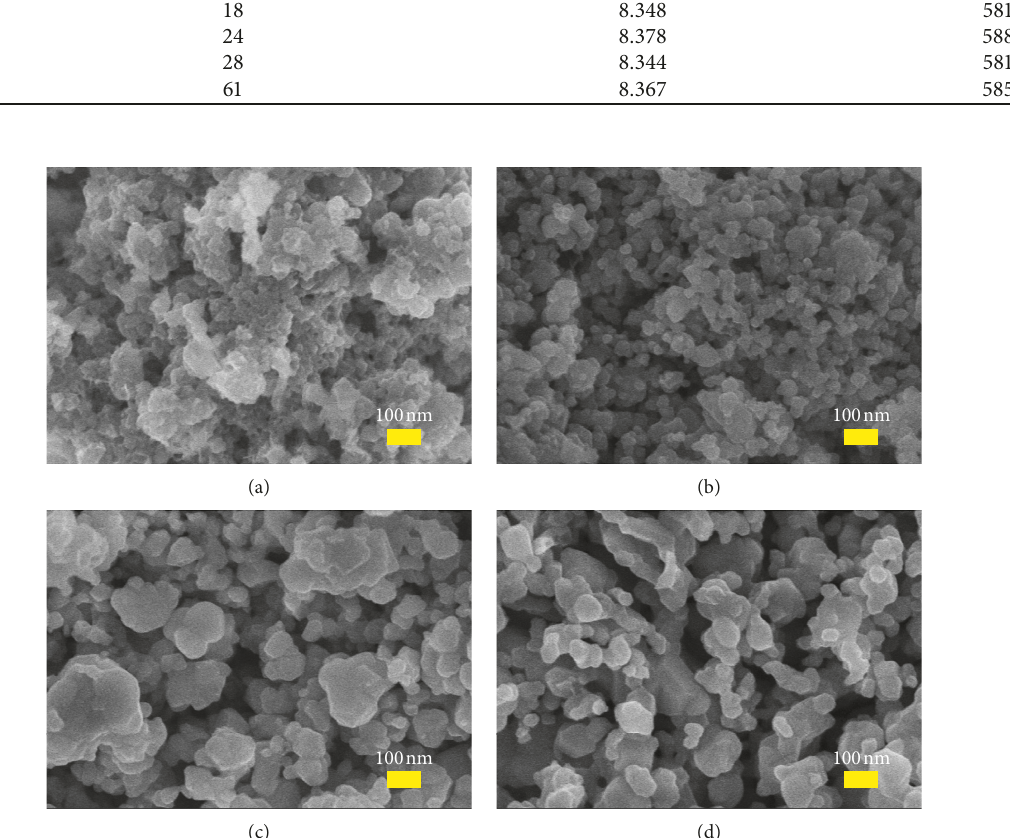
Table 1: Average crystallite size, lattice parameter, and unit cell volume of the samples at different calcination temperatures. t c ( ° C)